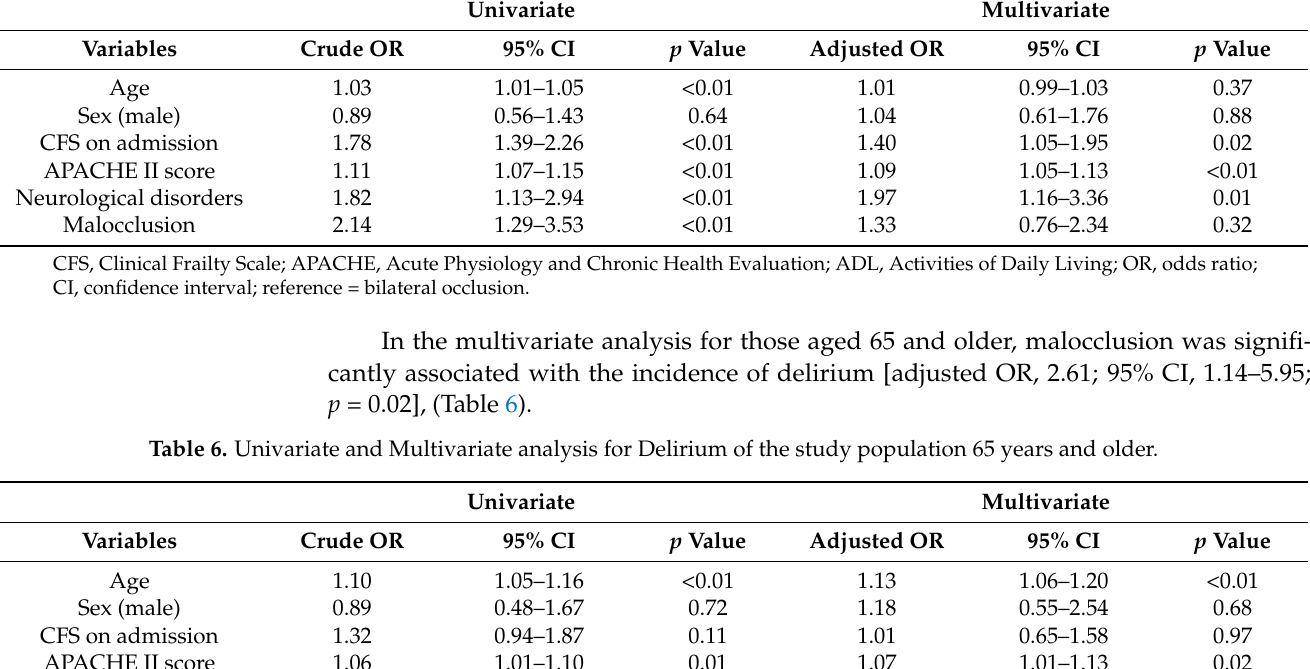
Table 5. Univariate and Multivariate analysis for Delirium of the study population. Univariate Multivariate